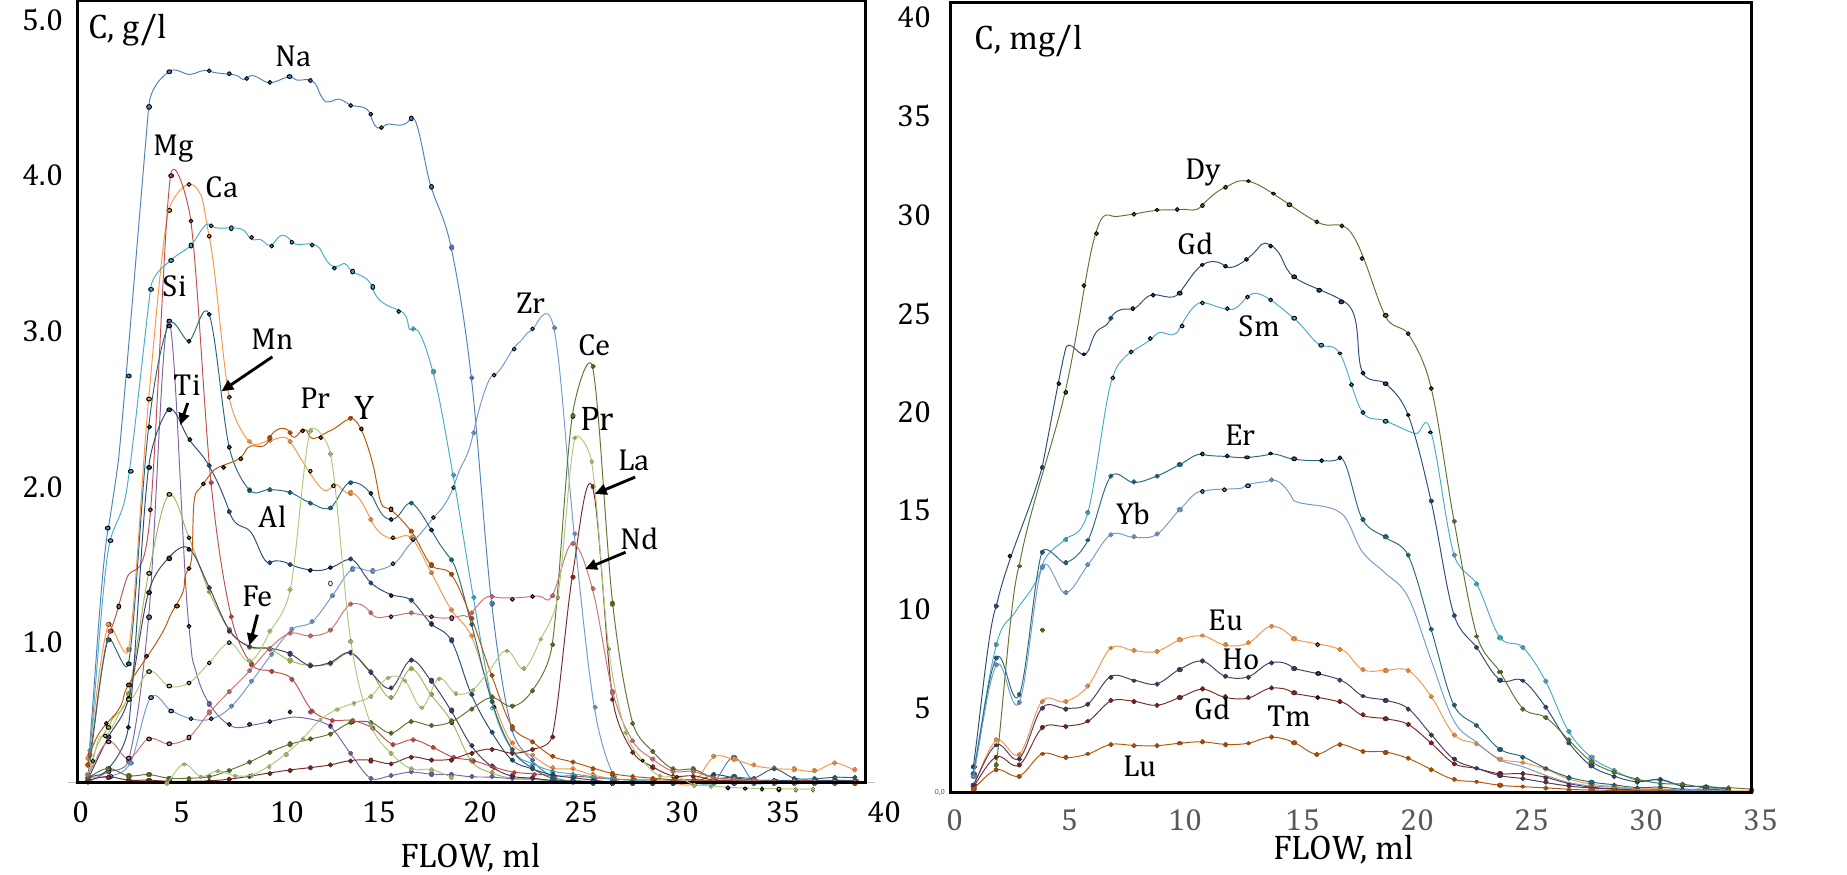
Figure 10. Refined REE solution elution curves through Purolite PCA-433.